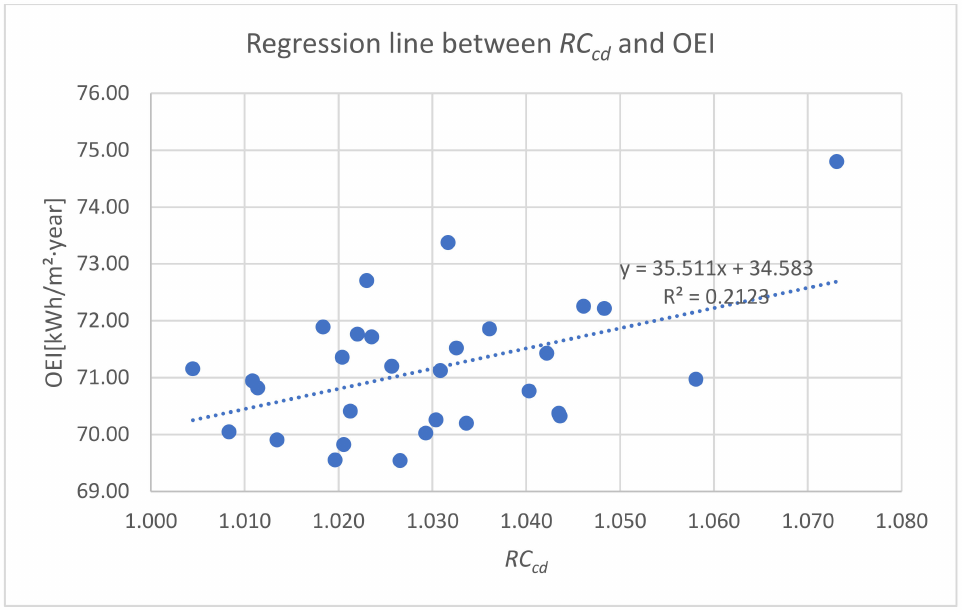
Figure 6. Weak correlation between RC cd and OEI in the case study of 30 single-family houses with highly dispersed building base area values ranging from 134.41 m 2 to 198.51 m 2